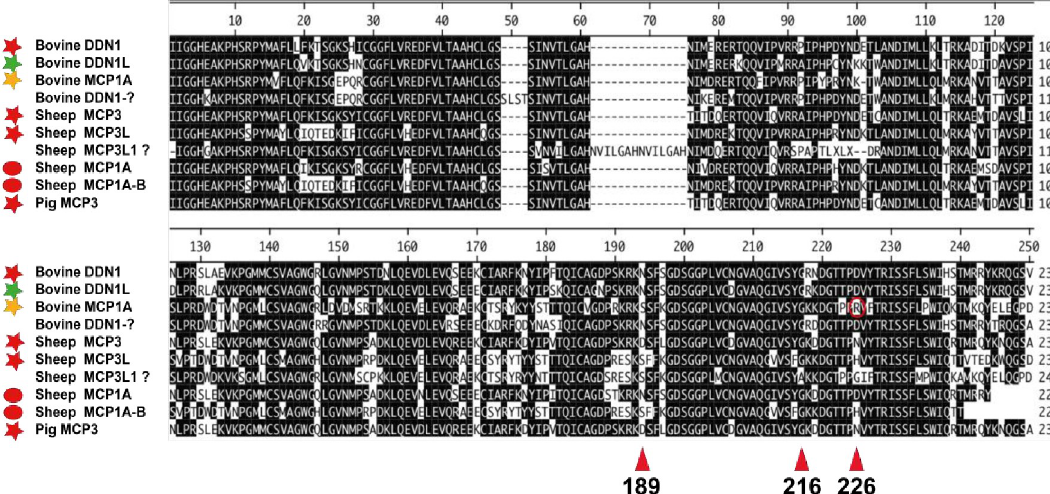
Fig 14. Sequence alignment of a panel of cow, sheep and pig duodenases. The figure shows the sequence alignment where three residues of importance for target selectivity are highlighted, residues 189, 216 and 226 (chymotrypsin numbering). These three residues form the catalytic pocket and as can be seen cow MCP1A differ from the other duodenases in position 226 where it has an Arg, which is marked by a red circle. This position is of major importance for its different primary specificity as being an asp-ase. Sheep DDN1-like lacks the N terminal part of the mature protease and is most likely a pseudogene.